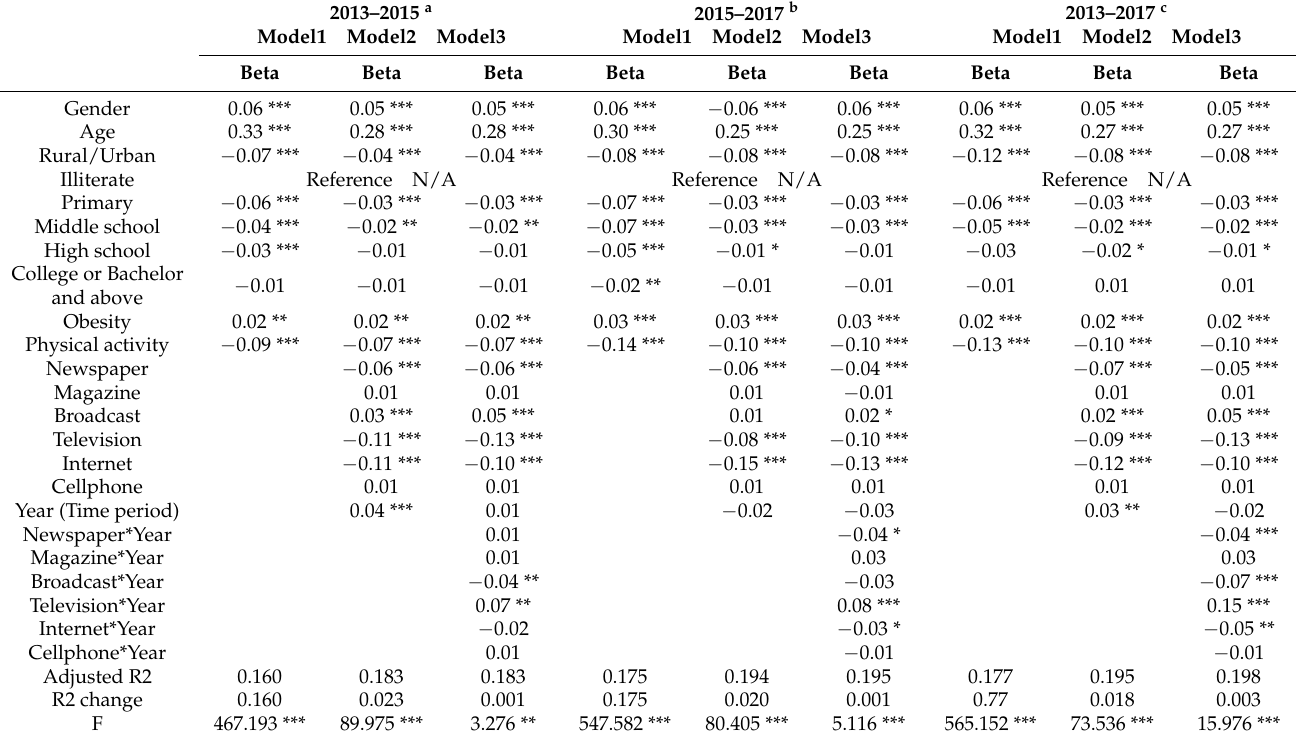
Table 5. Hierarchical multiple regression analysis for the change in associations between media use and SHS in 2013, 2015, and